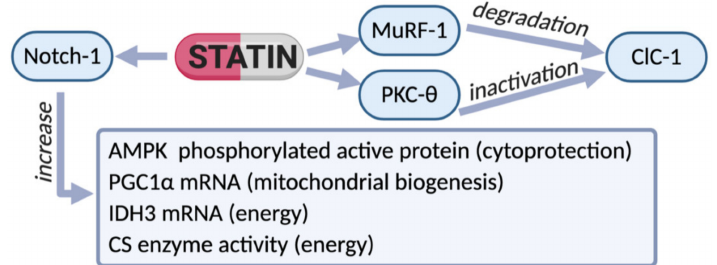
Figure 2. Scheme of the effects of therapy with statins observed in biopsies of patients experiencing myalgia and hyper-CK-emia. In these subjects a reduction of ClC-1 protein was observed, likely due to the increased degradation via MuRF-1 increase. In parallel, an increase of phosphorylated PKC-theta supports ClC-1 inactivation. However, an increased expression of Notch-1 (a protein found to raise during muscle cell proliferation) was observed in statin-treated patients, indicating effective regeneration. In accord, the phosphorylated form of AMPK was increased, suggesting the activation of restorative cytoprotective process. In an attempt to counteract energy deficit, compensative mechanisms were likely activated. Indeed, an increased expression of PGC-1-alpha and isocitrate- dehydrogenase (IDH3), together with increased activity of the enzyme citrate-synthase (CS), suggest mitochondrial biogenesis. Thus, the reduction of ClC-1 protein and consequent hyperexcitability in sarcolemma together with energy deficit seems to be among the most important alterations associated with statin-related risk of myopathy in